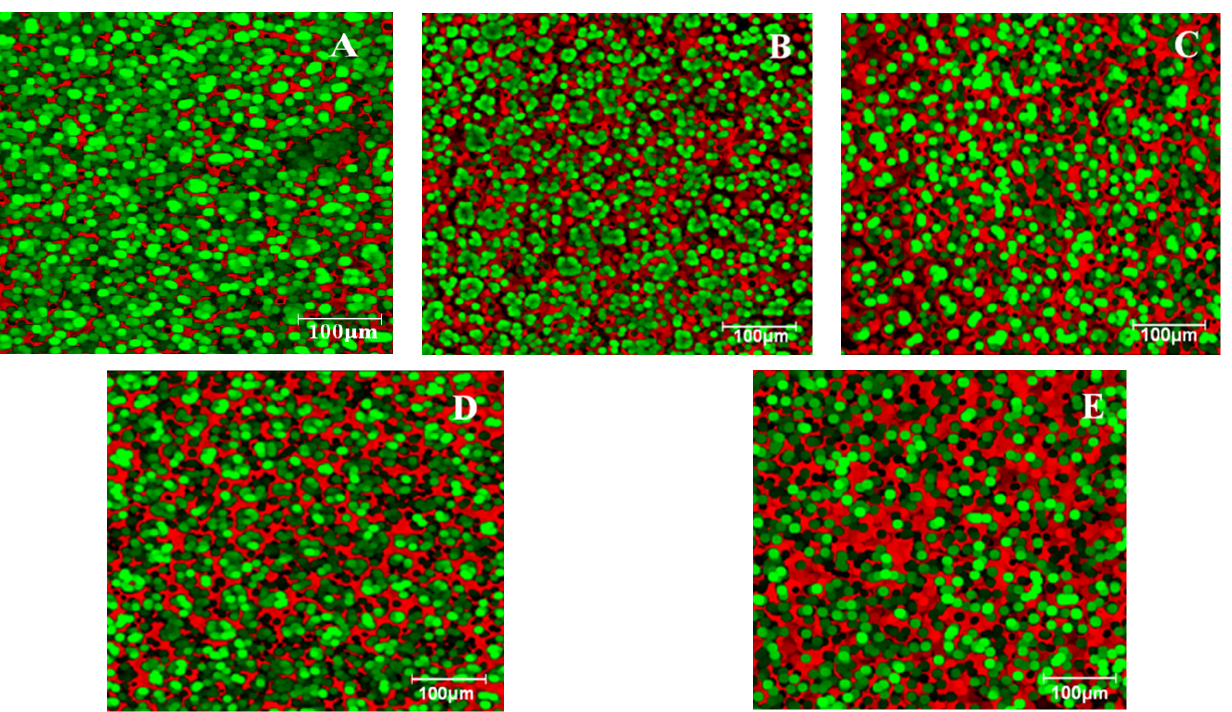
Figure 2. Microstructure measured by EFLM of the wheat dough with GSF in varying proportions: 0% ( A ), 5% ( B ), 10% ( C ), 15% ( D ), and 20% ( E ). Red, protein; green, starch granules.